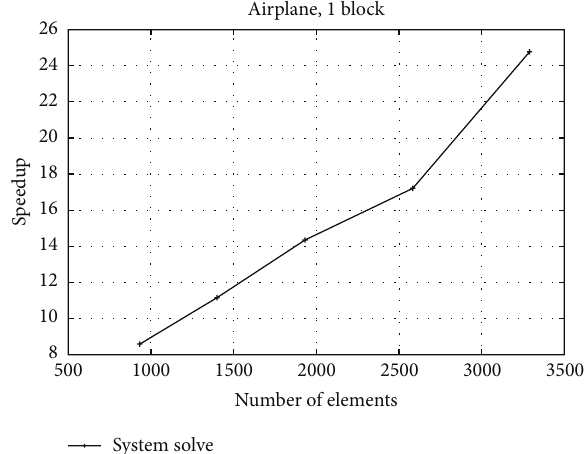
Figure 10: Speedup when solving the reduced linear system.